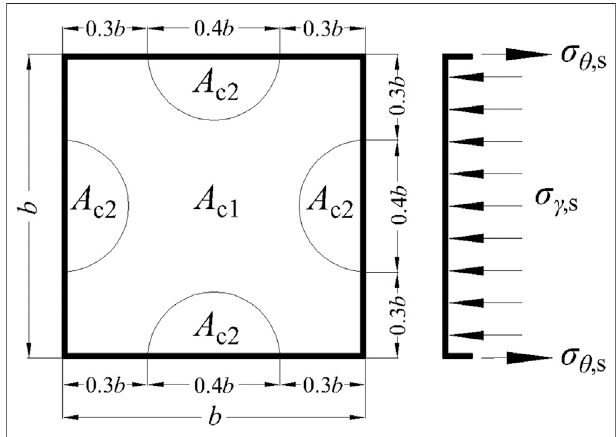
FIGURE 9 | Stress zone division of square concrete fi lled steel tubular columns.